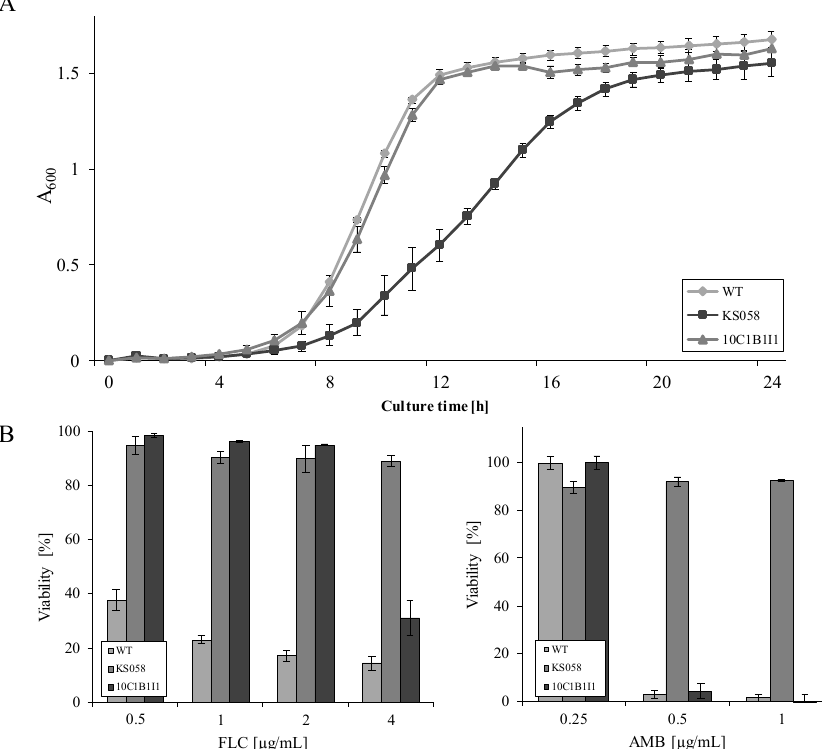
Figure 1. ( A ) The growth curve of the C. albicans SC5314 wild type (WT), erg11 Δ / Δ (KS058) and the ERG11 K143R/K143R (10C1B1I1) strains in a YPD medium (28 °C, 120 rpm; n = 3, ±SD). ( B ) The percent viability of the C. albicans WT, KS058, and 10C1B1I1 strains cultured for 24 h, 28 °C, in a YPD medium supplemented with FLC (left) or AMB (right) ( n = 3, ±SD).